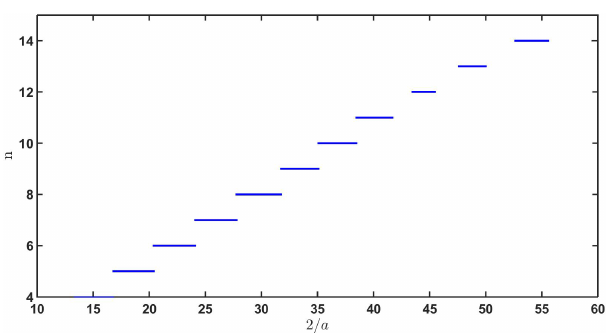
Figure 3. The dependence of the first critical wave number m = n on the scale factor a , assuming the Rossby number (cid:15) = 0 . 5 and the Ekman number E = 0 . 05 similar to Fig.